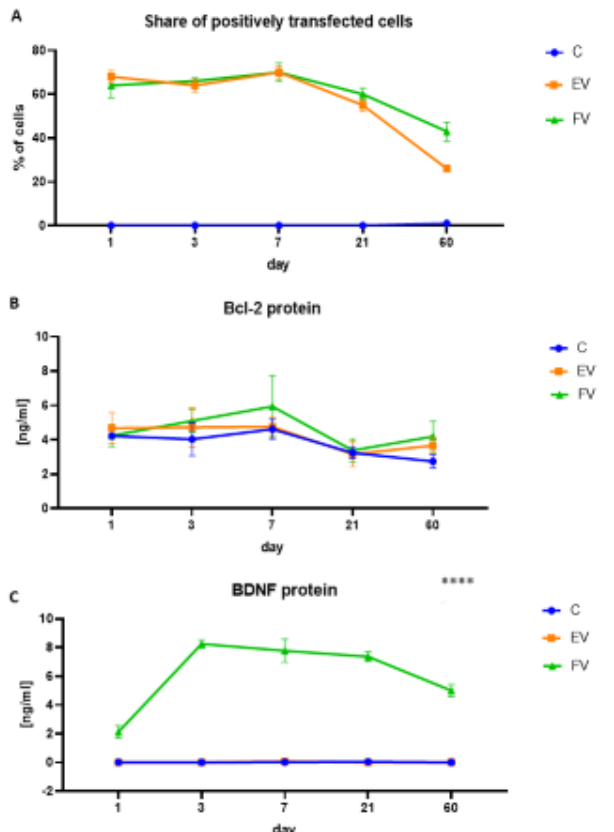
Figure 3. Transduction effects. Percentage of positive transduced cells over time ( A ). Quantitative analysis of the production of the Bcl-2 ( B ) and BDNF ( C ) proteins over time. Cells that were subjected to a synergistic vector transduction, which induced the overproduction of Bcl-2 and BDNF (full vectors—FV); empty vector transduced cells—(EV); control ( C ). In ( C ), the BDNF protein level of the EV group is the same as the C group (0 ng/mL all the time). The points represent the mean value ( n = 6; three independent experiments). Statistically significant p < 0.05, **** p < 0.0001; two-way ANOVA test followed by a post hoc Tukey’s test.